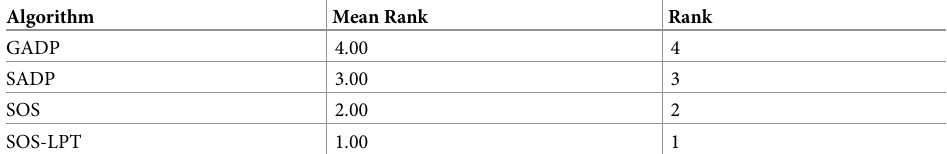
Table 8. Friedman’s rank test for the 120 instance combination of the benchmarked problem of GADP, SADP, SOS, and SOS-LPT using their average C max